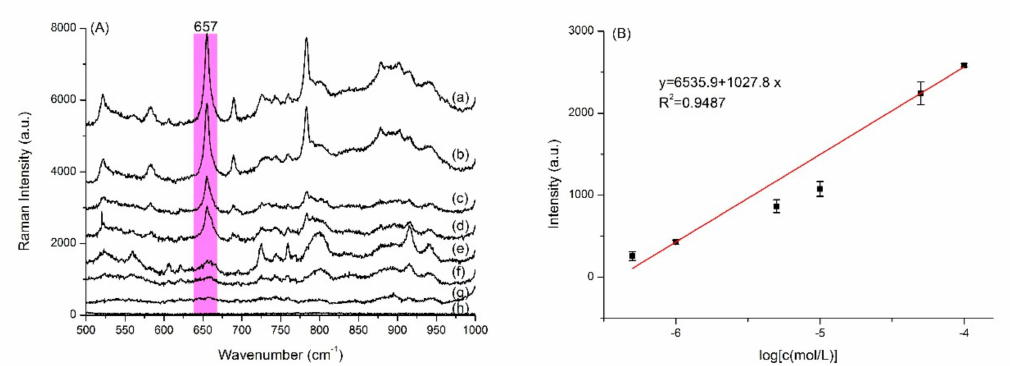
Figure 5. ( A ) Representative concentration-depend SERS spectra of (a) 1.0 × 10 − 4 , (b) 5.0 × 10 − 5 , (c) 1.0 × 10 − 5 , (d) 5.0 × 10 − 6 , (e) 1.0 × 10 − 6 mol · L − 1 , (f) 5.0 × 10 − 7 mol · L − 1 , (g) 1.0 × 10 − 7 mol · L − 1 purple color dye product from 2- 13 C-glyphosate (13–GLP) and (h) blank; the standard curve ( B ). Excitation wavelength: 633